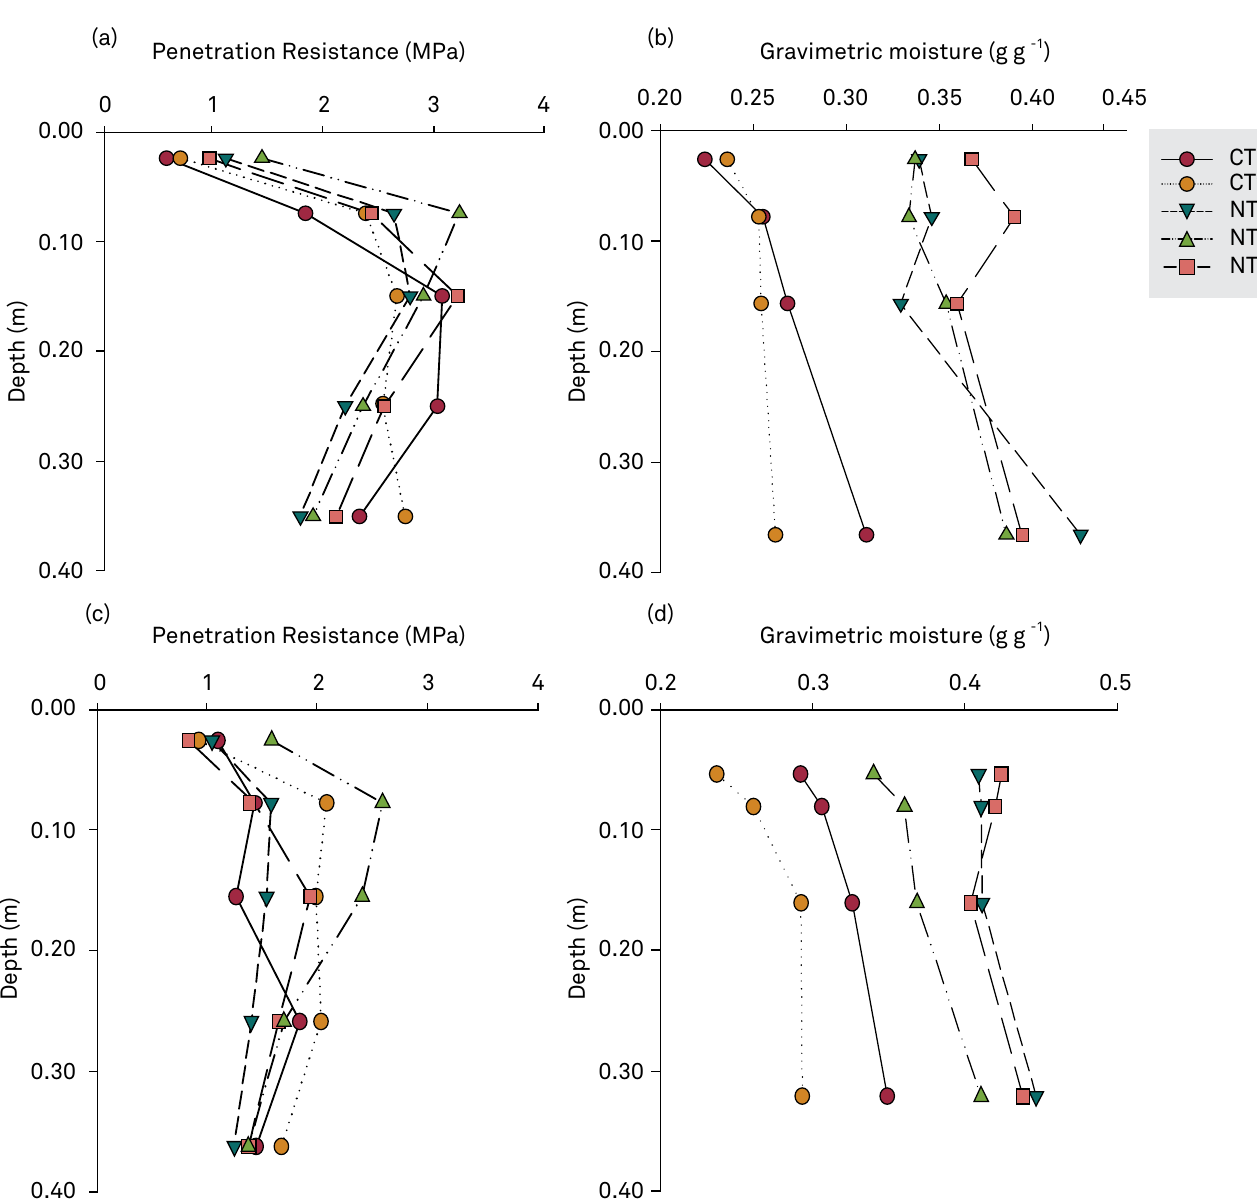
Figure 6. Penetration resistance (a, c) and gravimetric soil moisture (b, d) as affected by the tillage system and liming methods, in May 2009 (a, b) and March 2011 (c, d) in a Latossolo Bruno Alumínico típico (Hapludox). CTinc: conventional tillage with incorporated lime; CTwl: conventional tillage without lime; NTinc: no-tillage with incorporated lime; NTwl: no-tillage without lime; and NTsurf: no- tillage with surface